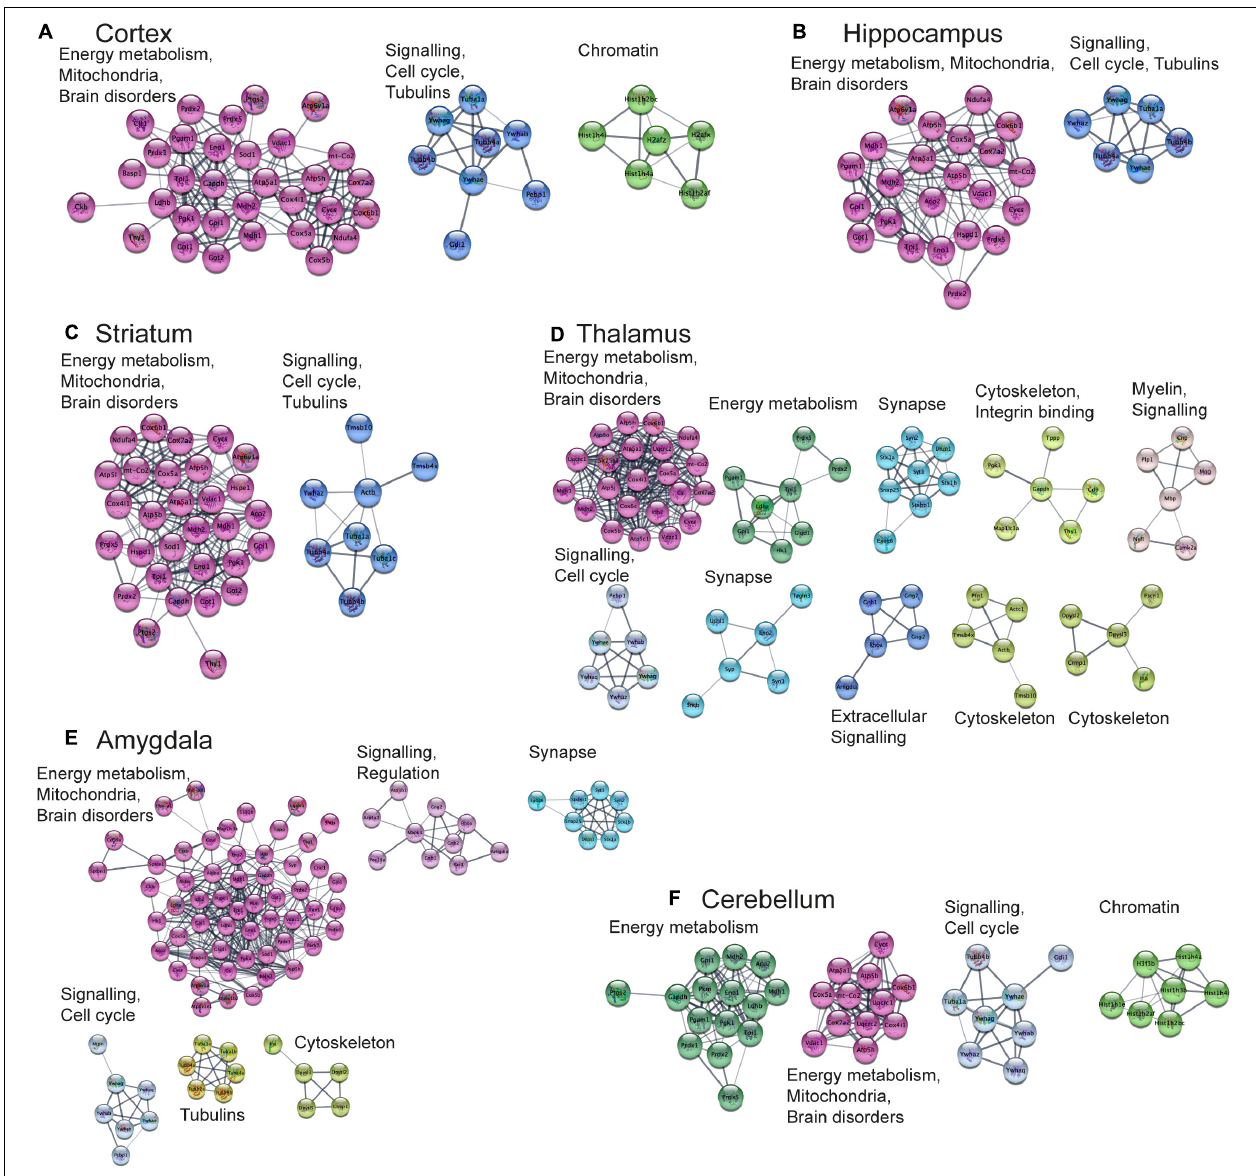
FIGURE 6 | Functional analysis of the most expressed proteins highlights shared functions in different brain regions. Networks of the most expressed proteins in different brain regions. (A–F) Nodes represent proteins. Edges correspond to all known relations between proteins based on STRING-Cytoscape (Shannon,